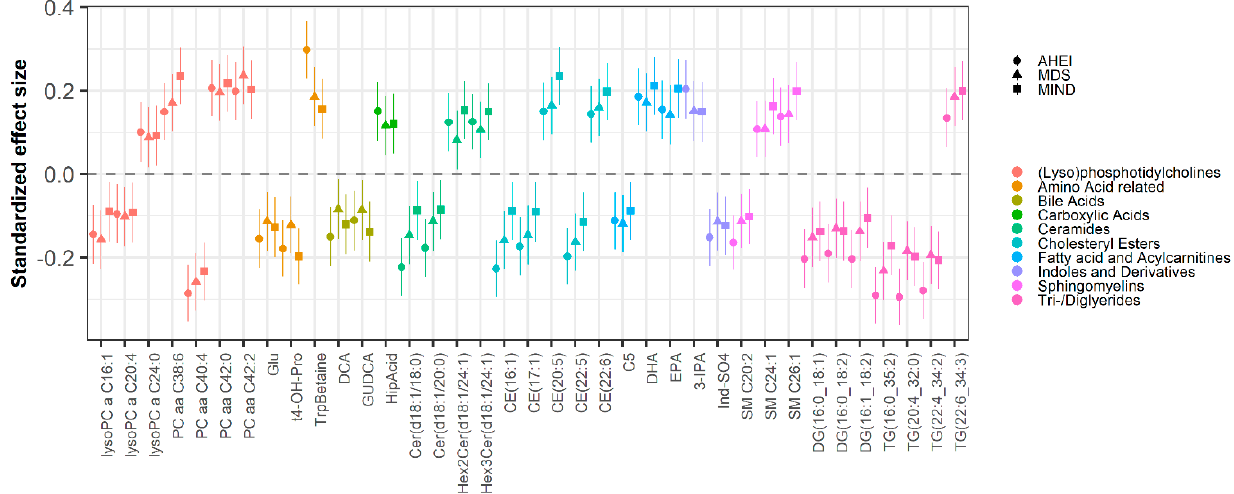
Figure 1. Association of plasma metabolites with Mediterranean diet score (MDS; triangle), Medi- terranean–DASH Intervention for Neurodegenerative Delay (MIND) score (square), and Alterna- tive Healthy Eating Index (AHEI) score (circle). The figure represents standardized coefficients from the regression model in which each metabolite is regressed on dietary patterns.